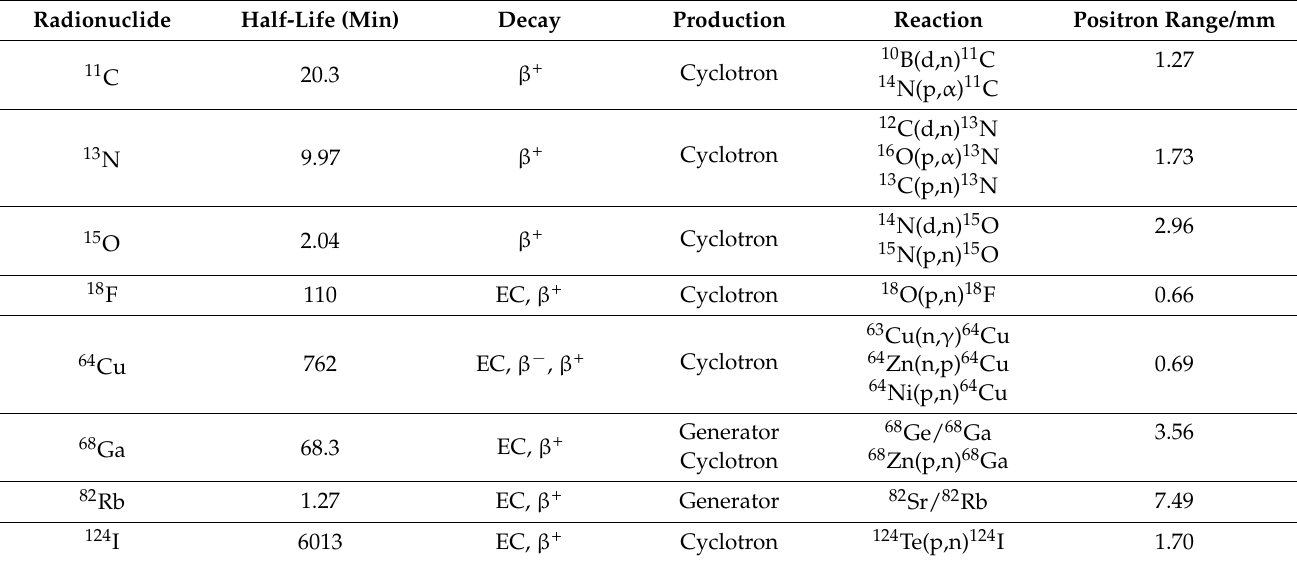
Table 1. The most common cardiac positron emission tomography (PET) radioisotopes. Decay